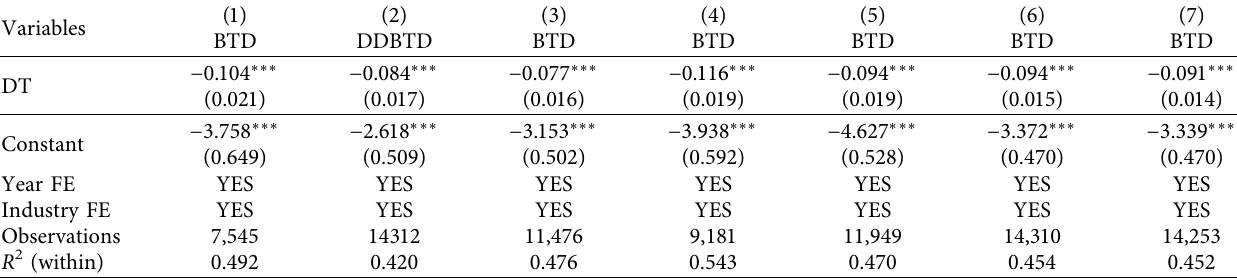
Table 8: Robustness